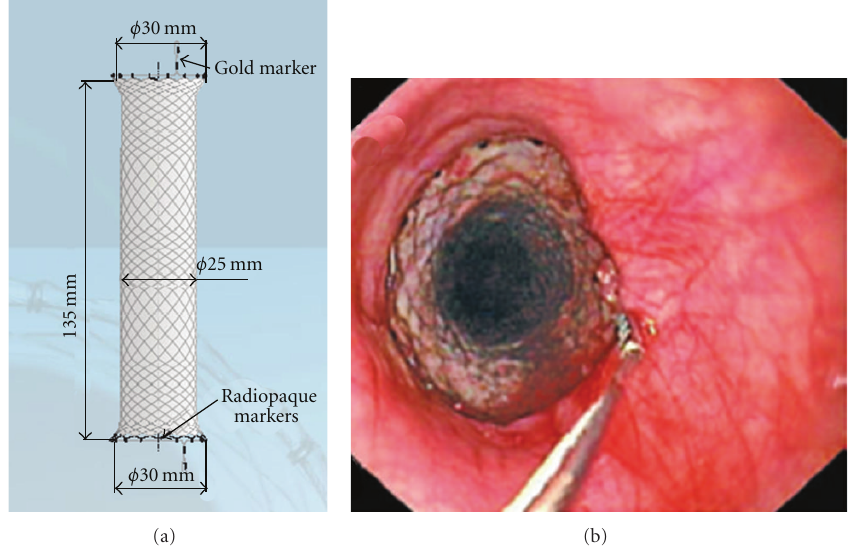
Figure 3: (a) Design of the SX-Ella Danis stent including radiopaque markers as well as the gold markers for stent removal. (b) Endoscopic view of the esophagus with the proximal end of the stent showing the extraction loop (gold marker).